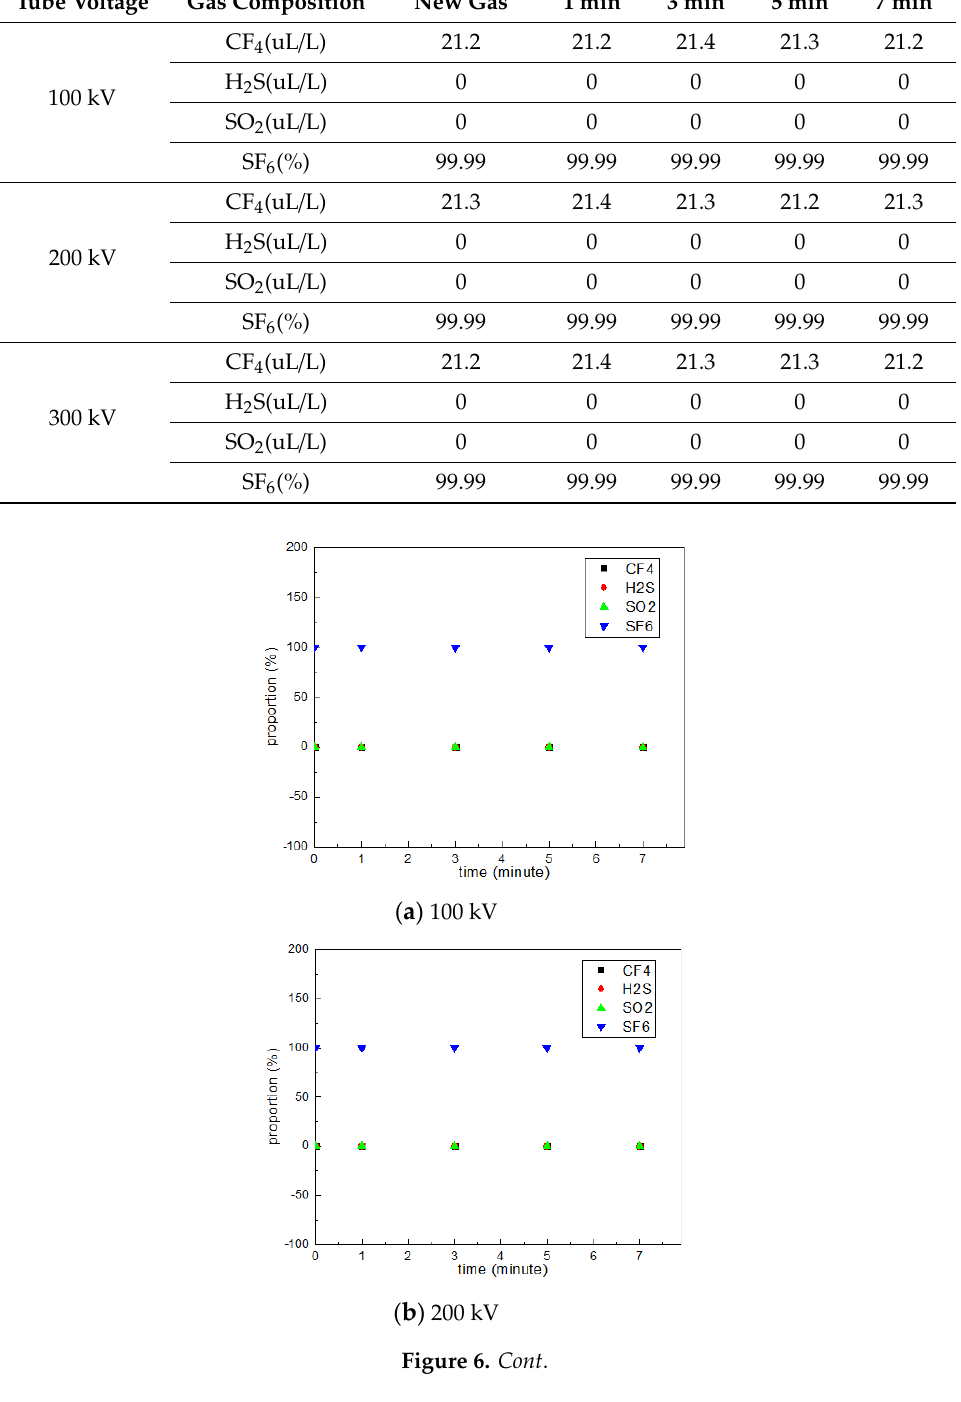
Table 1. Gas composition results under di ff erent voltages.